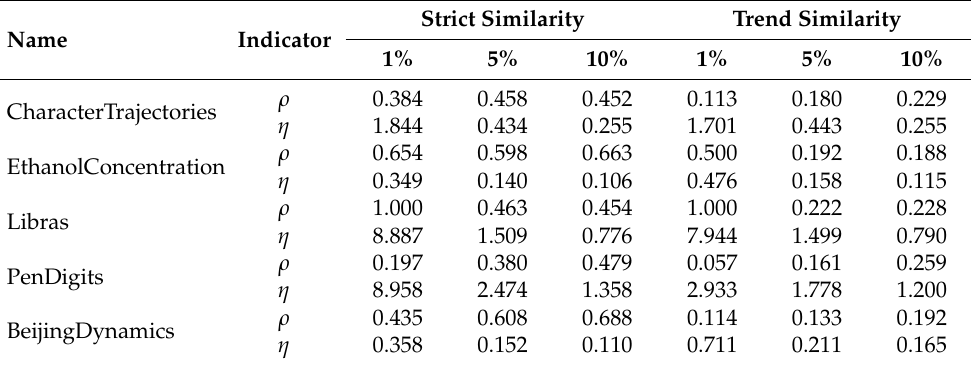
Table 2. Comparisons between the proposed method and the reference